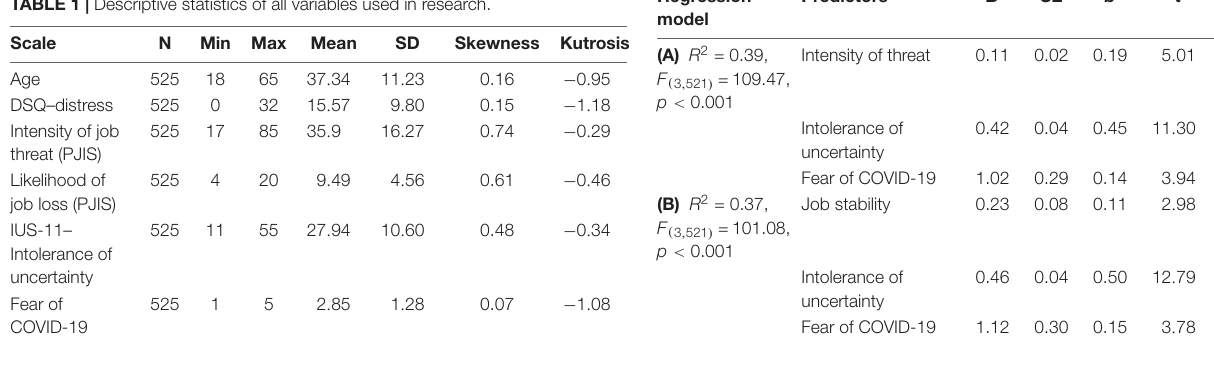
TABLE 1 | Descriptive statistics of all variables used in research.